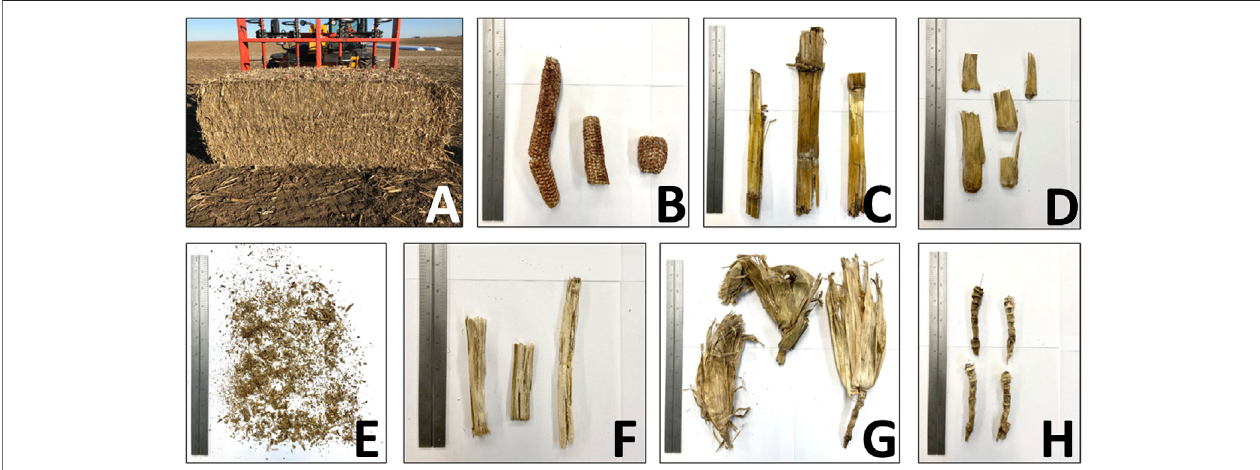
FIGURE 1| Images ofthe harvested corn stover and respective plant fractions ofinterestfor further isolation. These include (A) the corn stover rectangular bale as harvested, (B) cob, (C) stalk, (D) sheath, (E) leaf fractions pulverized during harvesting operations, (F) pith isolated from stalk fractions, (G) is the husk with attached shank, and (H) isolated shank found attached to the stalk and husk plant